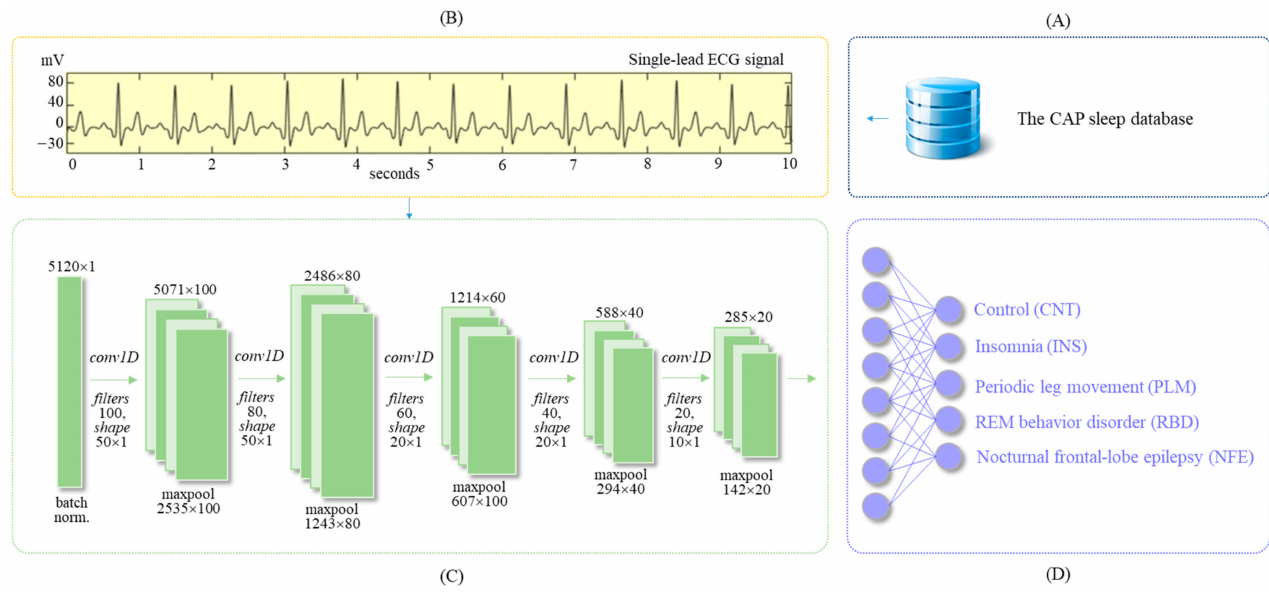
Figure 1. Schematic diagram of this study. ( A ) CAP sleep database, ( B ) ECG dataset, ( C ) deep learning model, and ( D ) Outputs.